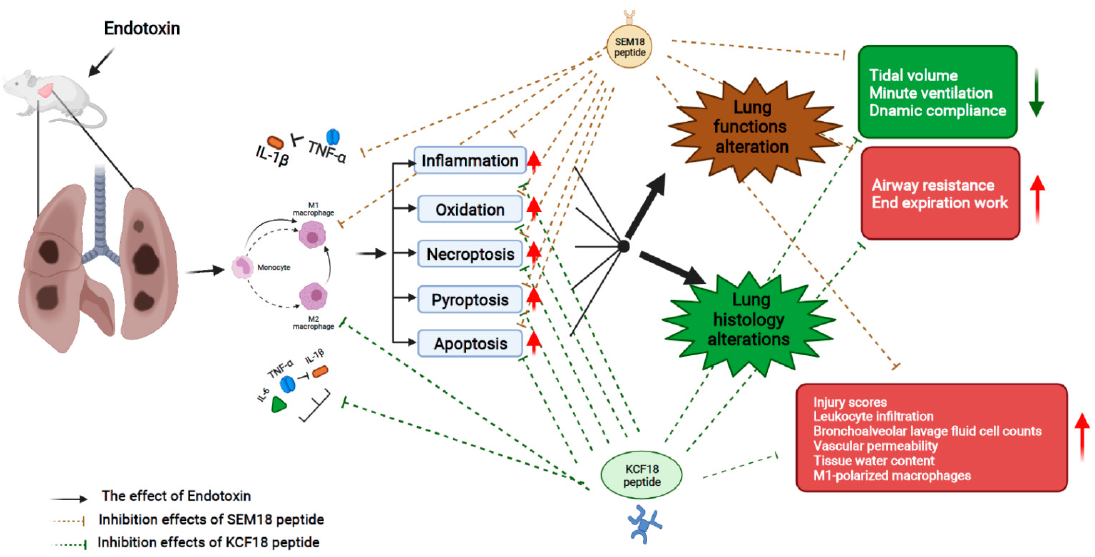
Figure 9. The diagram illustrating the effects and mechanisms of inhibiting the early response cytokines tumor necrosis factor- α (TNF- α ), interleukin-1 β (IL-1 β ) and/or interleukin-6 (IL-6) (as achieved by the novel peptides KCF18 and SEM18) on inhibiting endotoxin-induced lung injury in the early phase of endotoxemia (i.e., 24 h after endotoxemia induction) in mice.